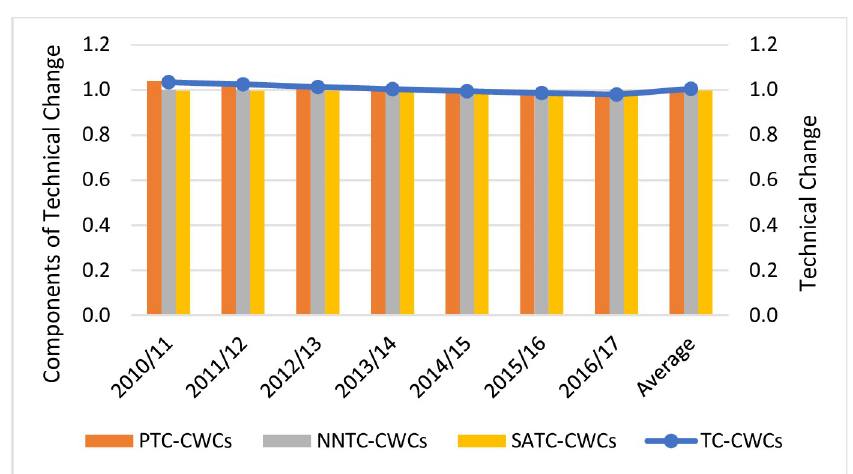
Fig 4. Technical Change (TC) estimations and its components (pure technical change -PTC-, non-neutral technical change -NNTC and scale-augmenting efficiency change -SATC-) for Chilean concessionary water companies